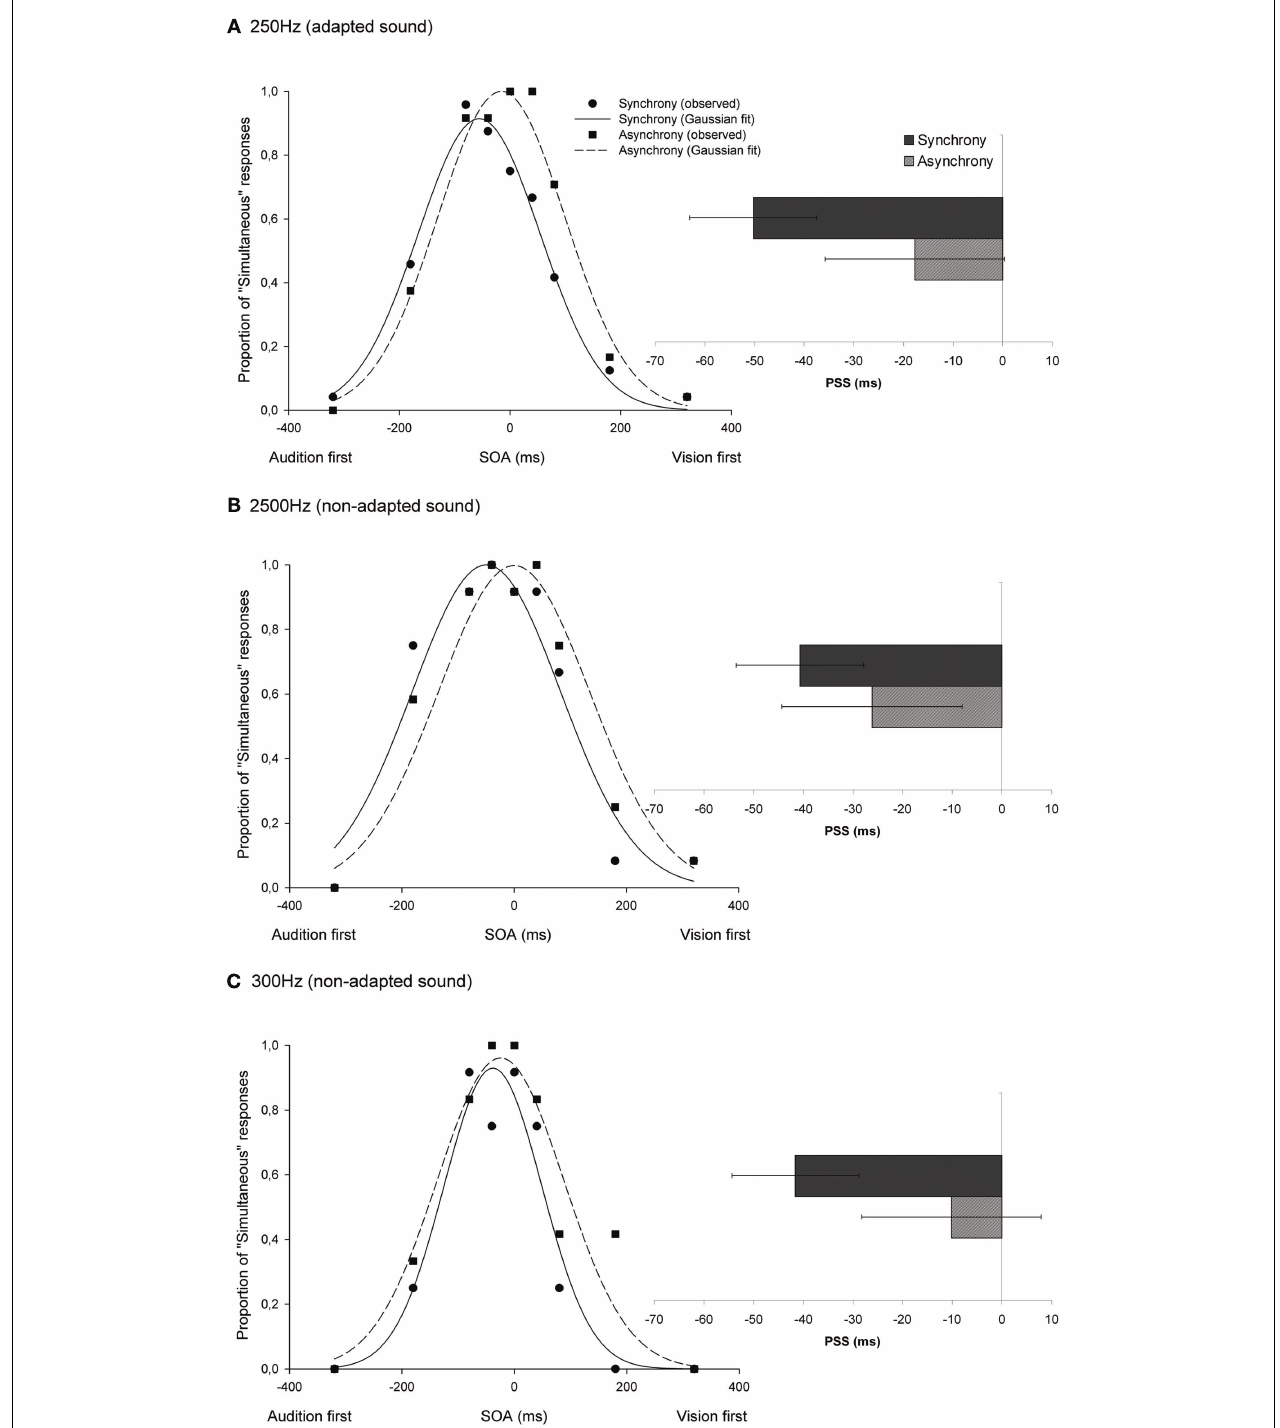
conditions, including data (mean and standard error) from all of the participants.When audiovisual stimuli were presented asynchronously during the exposure phase, a temporal shift was observed (see dashed lines), in the PSS, toward the direction of the asynchrony (vision-first), and regardless of the sound being tested.The sensitivity to physical synchrony decreased (i.e., the SD increased) as a result of exposure to